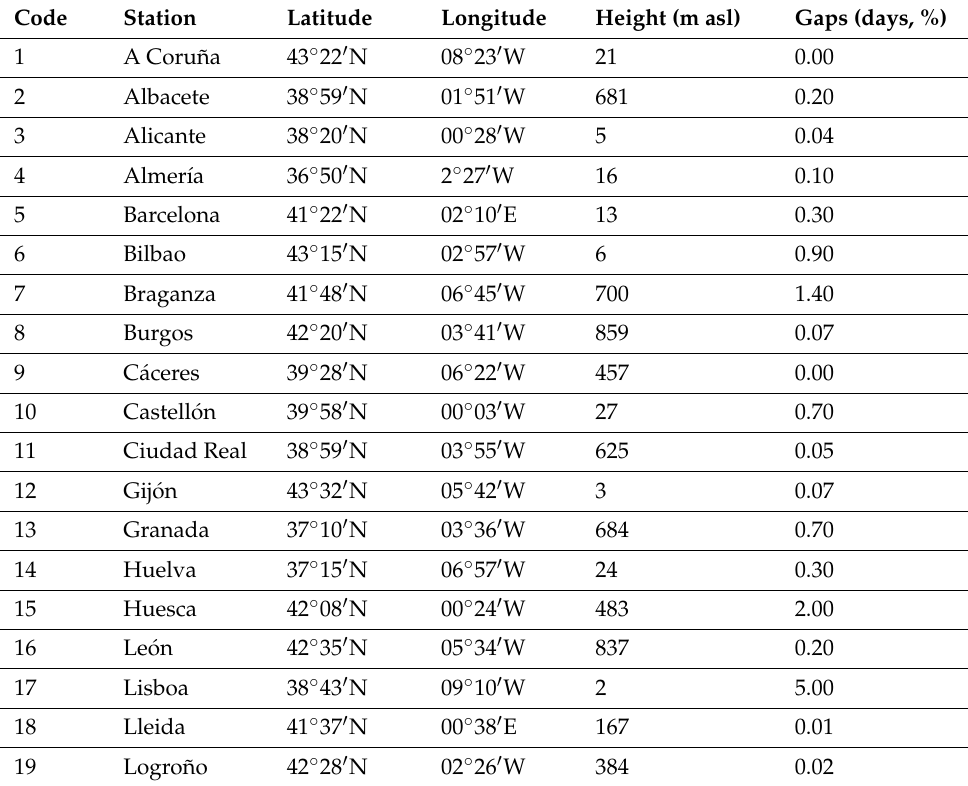
Figure 2. Map with the 35 stations selected In the Iberian Peninsula (numerical code in Table 1 is included). Table 3. Meteorological stations studied in this work (data from